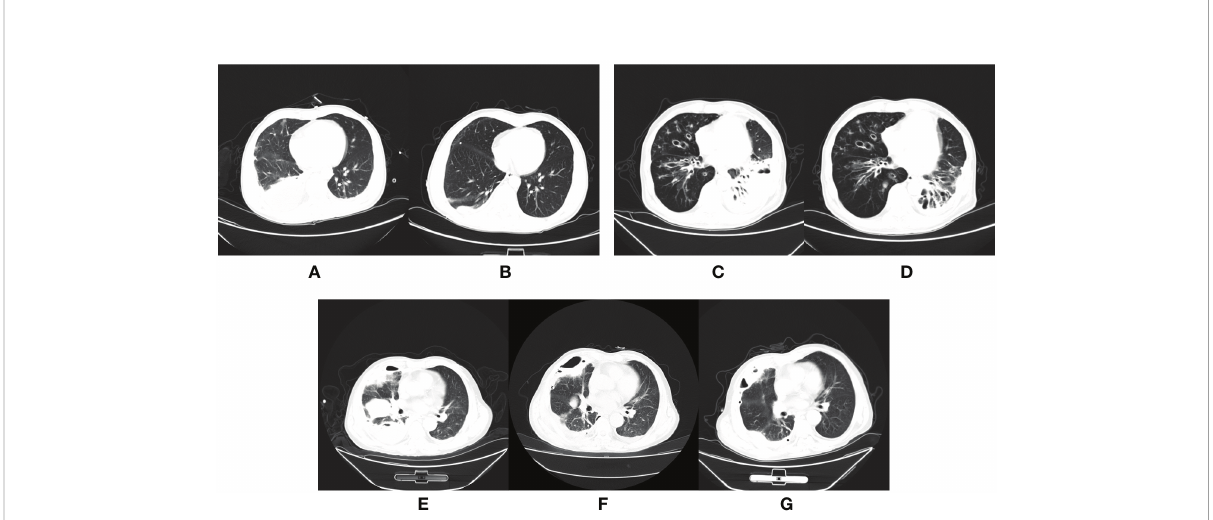
FIGURE 4 The CT scan of aspiration pneumonia. Chest CT of a patient who was in good health showed moderate right-sided pleural effusion on the day of admission (A) and a signi fi cantly reduced, small amount of right-sided pleural effusion before discharge from the hospital (B) . Chest CT of a patient with hypertension, and previous cerebral infarction showed in fl ammation of the left lower lobe of the lung on admission (C) and partial absorption after targeted antibiotic treatment for two months (D) . Chest CT of a patient showed a large area of in fl ammation and a partial cavity in the right lung on the day of admission (E) ; the in fl ammation was partially absorbed, but the cavity became larger after targeted antibiotic treatment (F) , and smaller after absorption of in fl ammation postoperatively (G)